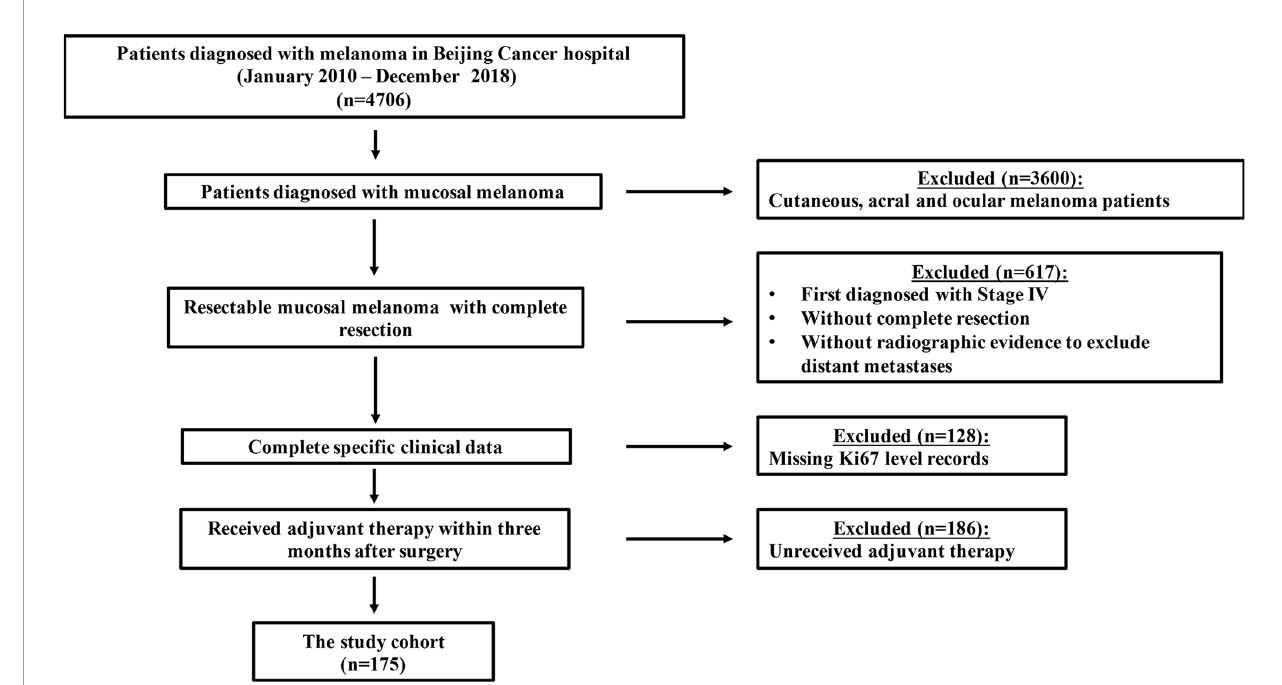
FIGURE 1 | Flowchart of inclusion and exclusion criteria for this study. A total of 1106 MM patients were screened from a database of 4406 patients, and 175 patients were fi nally